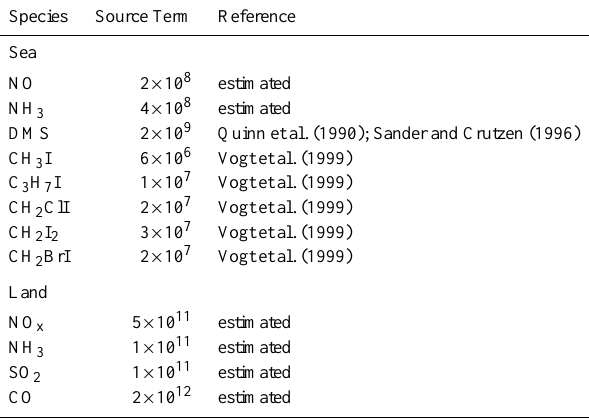
Table 3. Gas-phase source terms, in moleculescm − 2 . The Sea terms are used for the Atlantic and Channel legs of the model run (and for the sea-section of the Roscoff leg). The Land terms are used for the UK leg of the model run – the NO x term is split between NO and NO 2 based on the NO : NO 2 of the lowest level of the model column at that point in